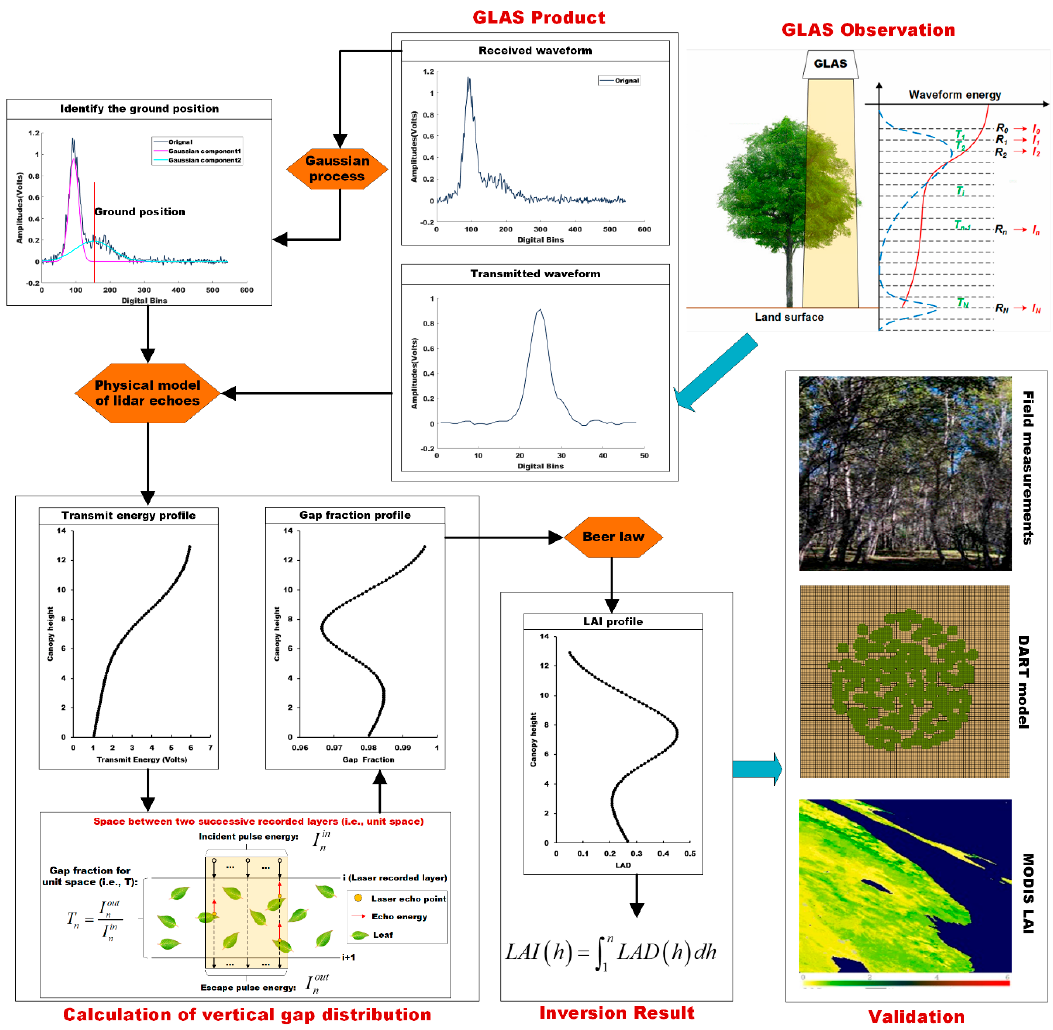
Figure 2. Workflow diagram for retrieving vertical foliage profile (VFP) and LAI from GLAS data.